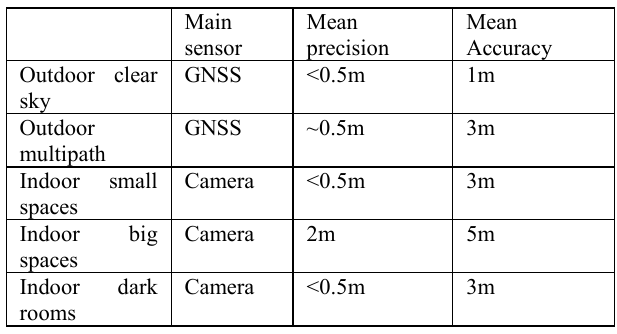
Table 4 . IOPES system horizontal performance at “PMT- buildings” test